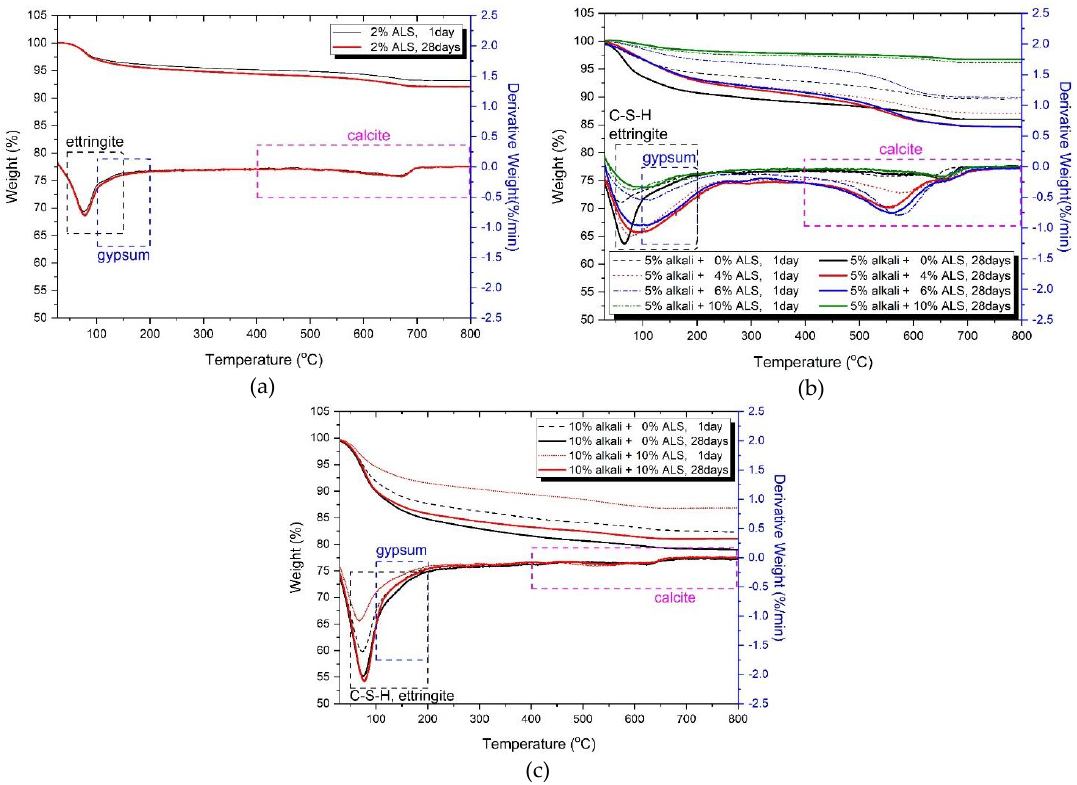
Figure 7. TG and DTG analysis for ( a ) 2% ALS (without alkali), ( b ) 5% alkali + ALS, and ( c ) 10% alkali + ALS. alkali + ALS. Table 4. Temperature ranges for identifying the phases via TG (or DTG), DTA and